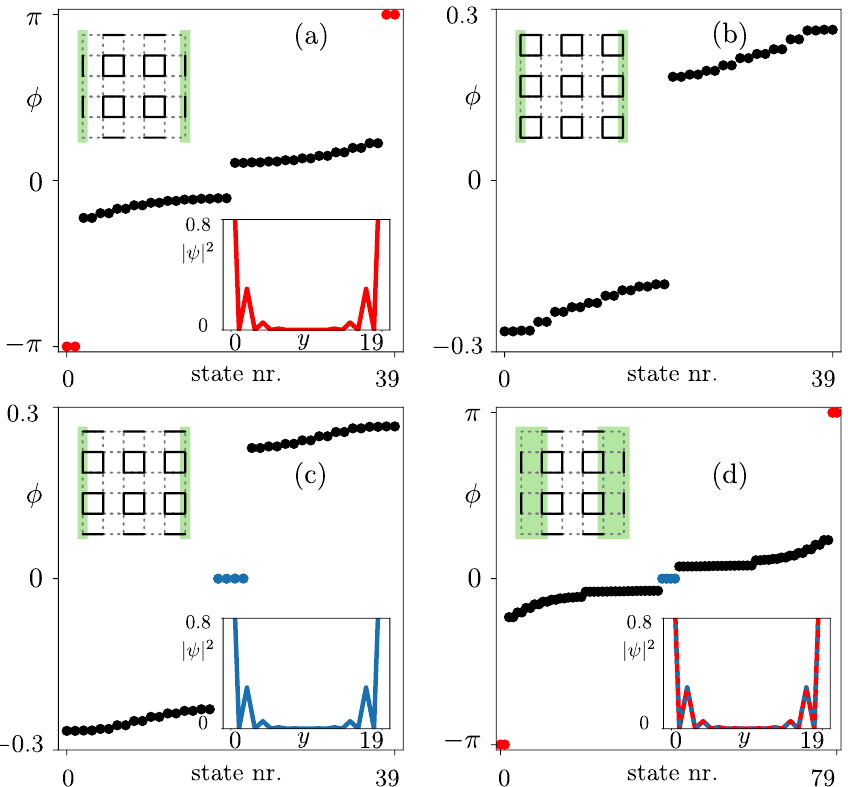
Figure 4: Eigenphases of the reflection matrix, showing π -modes (0-modes) and their associated wavefunctions in red (blue). We consider a bilayer of HOTI systems, each = 1 and D = D = 0.15. We have chosen with 20 × 20 sites. In all panels, λ x , y x y γ = 0.4 in panels (a) and (d), γ = 1.2 in panel (b), whereas γ = 1.2 and x , y x , y x γ = 0.4 in panel (c). Insets sketch the corresponding dimerization pattern of the y HOTI as well as the sites connected to the lead (green). The system-lead coupling = 0.5 in all strength is t sl